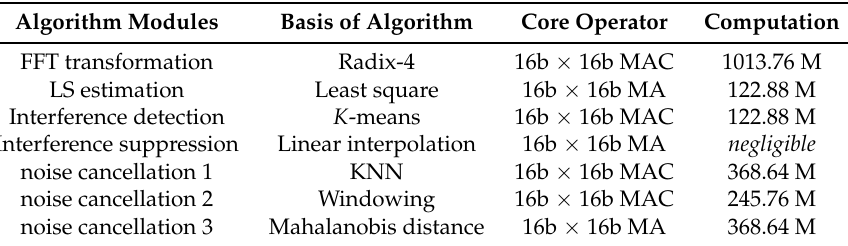
Table 1. Computation of algorithm modules.